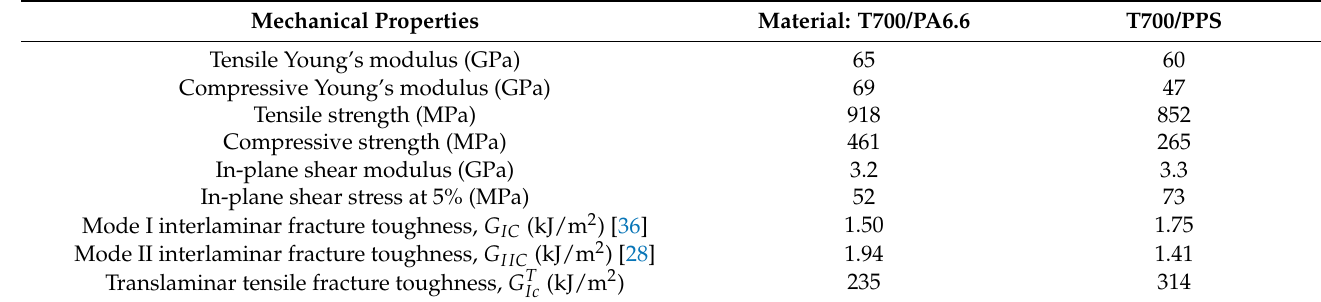
Table 2. Quasi-static mechanical properties of T700/PA6.6 (FVF = 52%) and T700/PPS (FVF = 61%) [28,34,35]. Mechanical